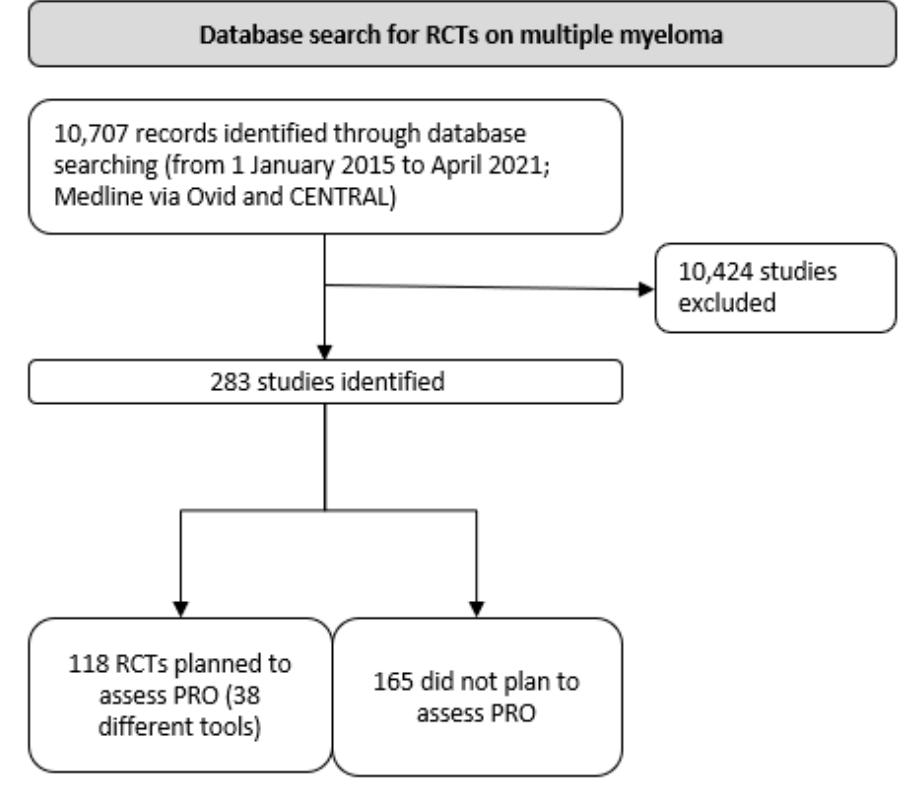
Figure 1. PRISMA flow diagram.